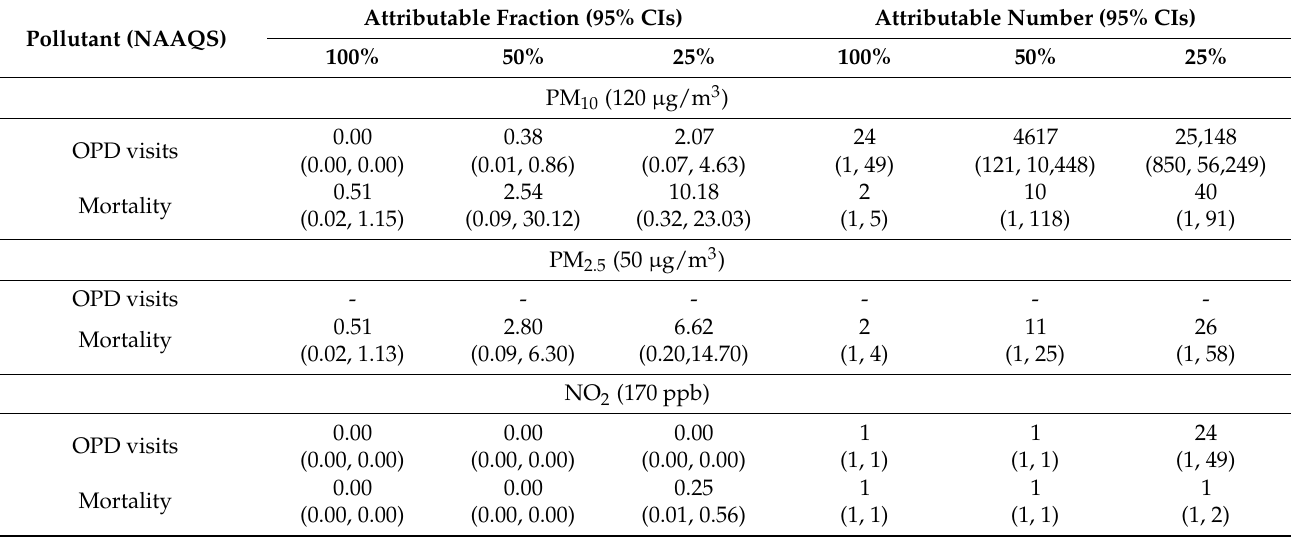
Table 14. Attributable fractions and attributable numbers of outpatient department (OPD) visits and mortalities for skin and subcutaneous tissue diseases caused by air pollutant concentrations in